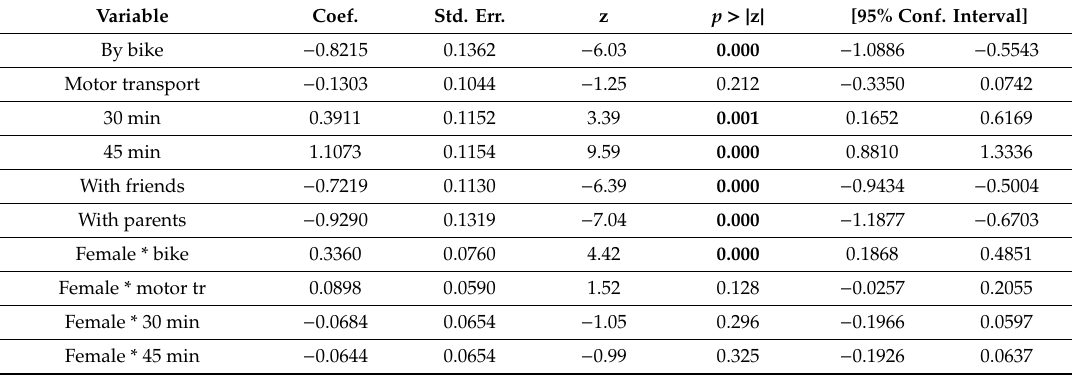
Table A7. Analysis of interaction e ff ects driving adolescents’ preferences: full model considering together (i) adolescents’ socio-demographics and personal characteristics; (ii) city size / typology where adolescents live; (iii) type of